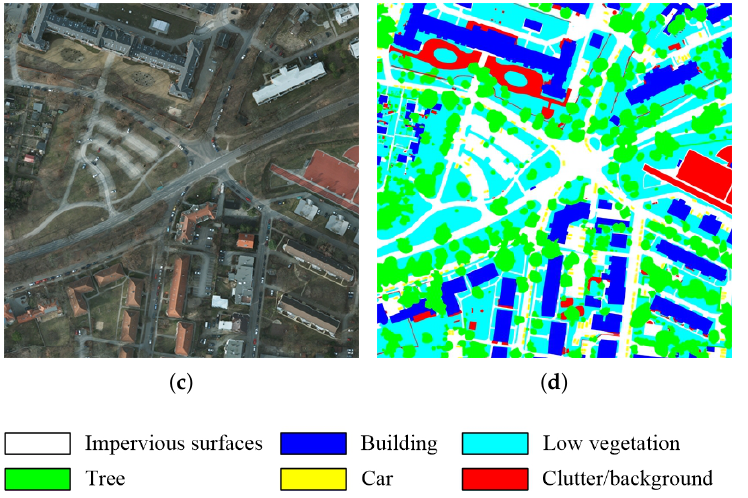
Figure 5. Images from Potsdam: ( a ) 2_10 RGB; ( b ) 2_10 ground truth; ( c ) 3_10 RGB; ( d ) 3_10 ground truth. Table 2. Numbers of ground-truth pixels for all categories in two selected images from